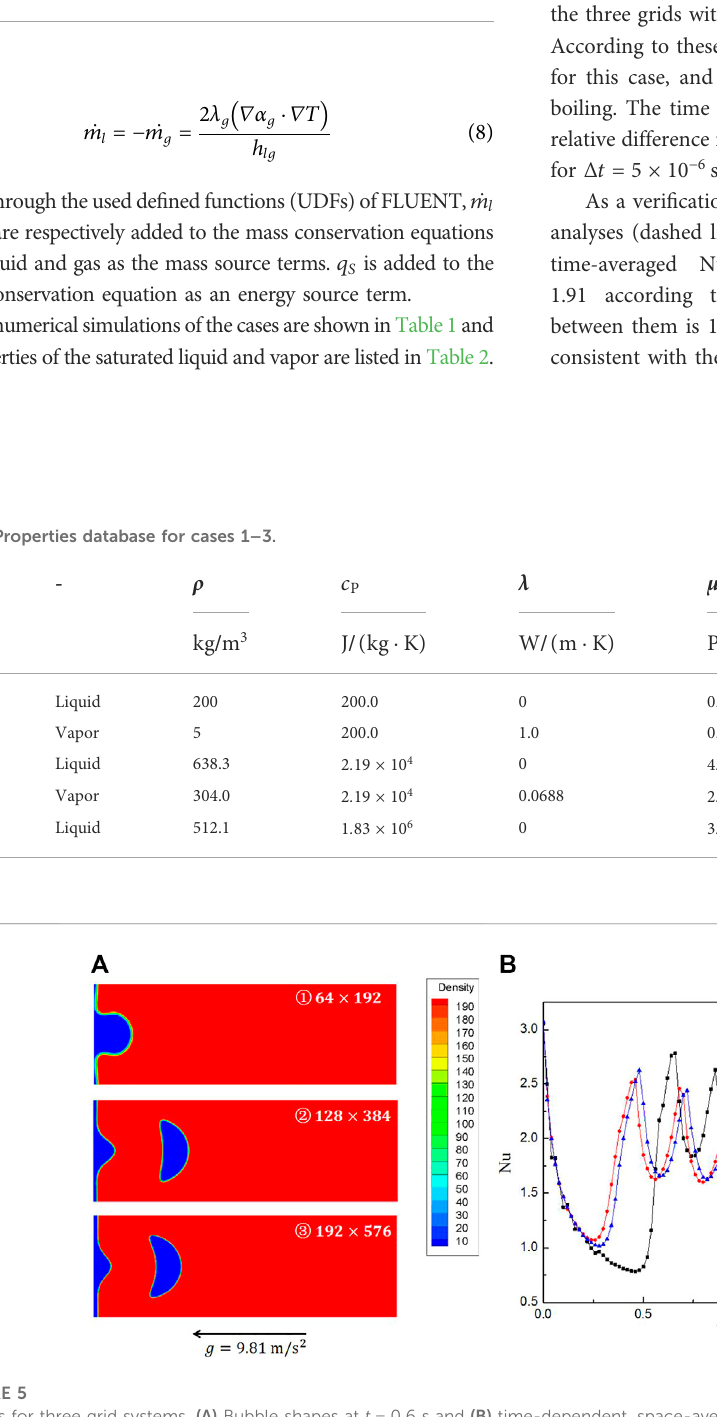
FIGURE 5 Results for three grid systems. (A) Bubble shapes at t (cid:1) 0 . 6 s and (B) time-dependent, space-averaged Nusselt